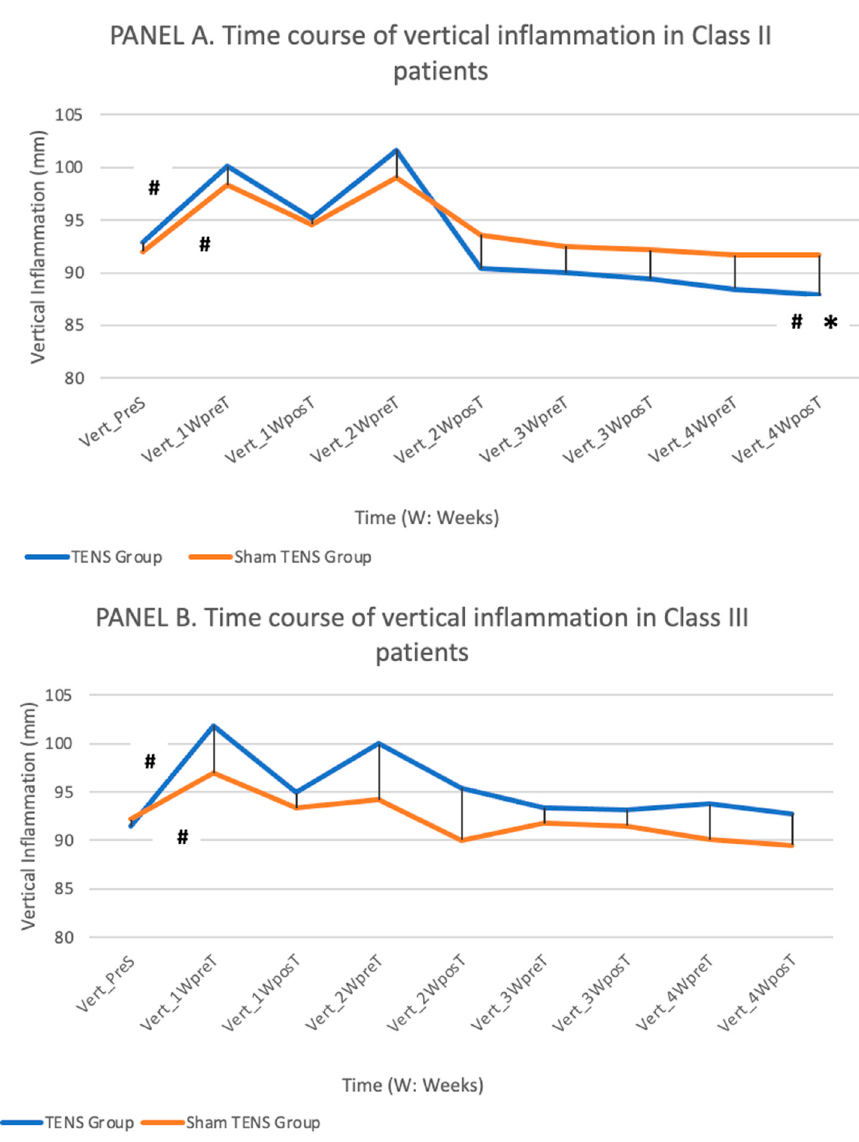
Figure 6. Depicts the time course of vertical inflammation values in the TENS and sham-TENS groups of class II patients ( A ) and class III patients ( B ) over the study period. ( # significant differ- ences ( p < 0.05) between different time points in the same group, * significant differences ( p < 0.05) between groups).